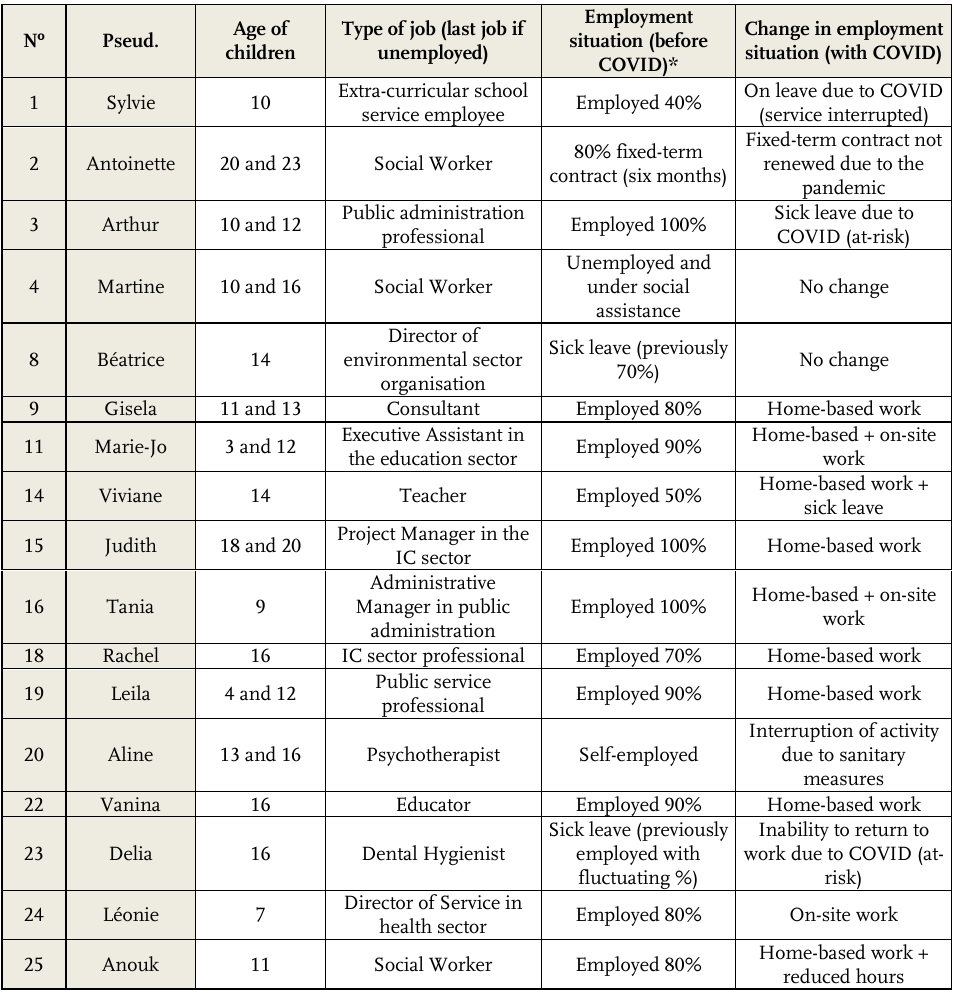
Table A.1 : Sample characteristics and changes in main life domains triggered by the